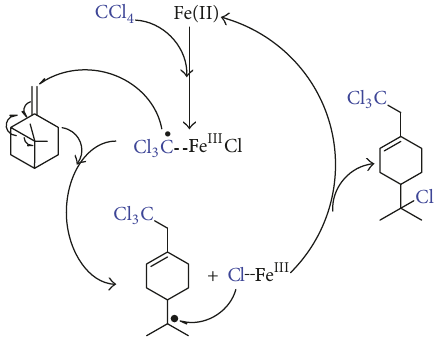
Scheme 2: Proposed mechanism for the cyclobutane opening ring of 𝛽 -pinene in Kharasch addition of CCl 4 catalyzed by Fe(acac) 2